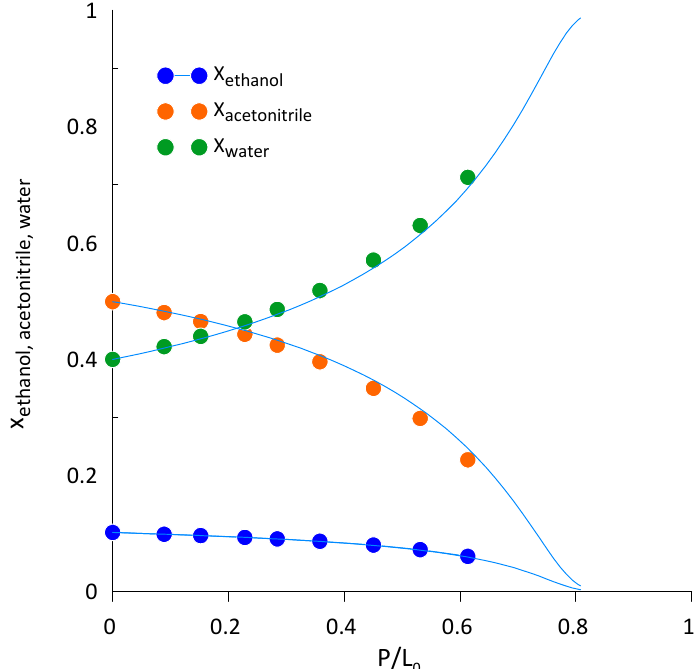
Figure 14. Residual curves for a mixture of ethanol-acetonitrile-water, geometric fig- ures—experimental data, line—calculation by the UNIFAC method (Table